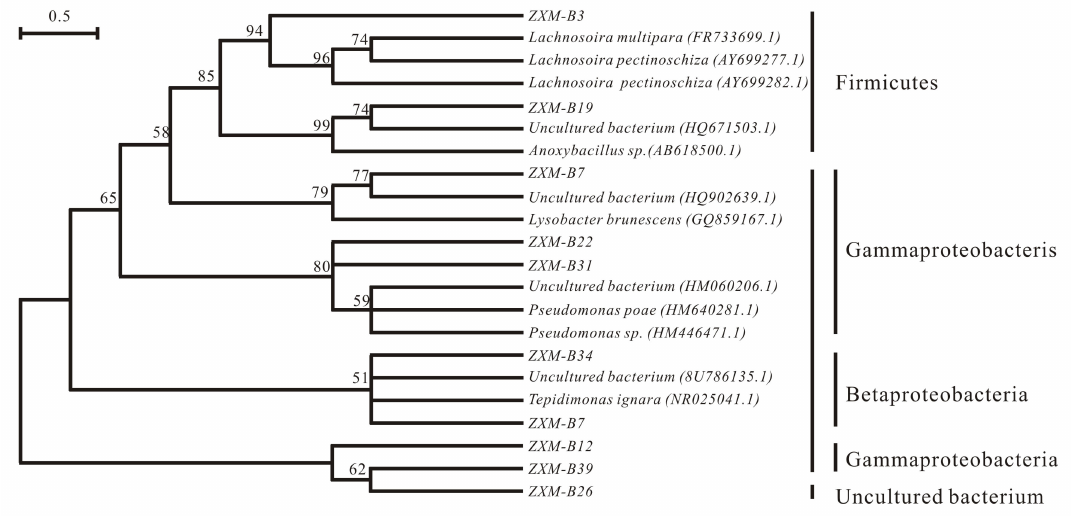
Figure 7. Phylogenic tree of rumen